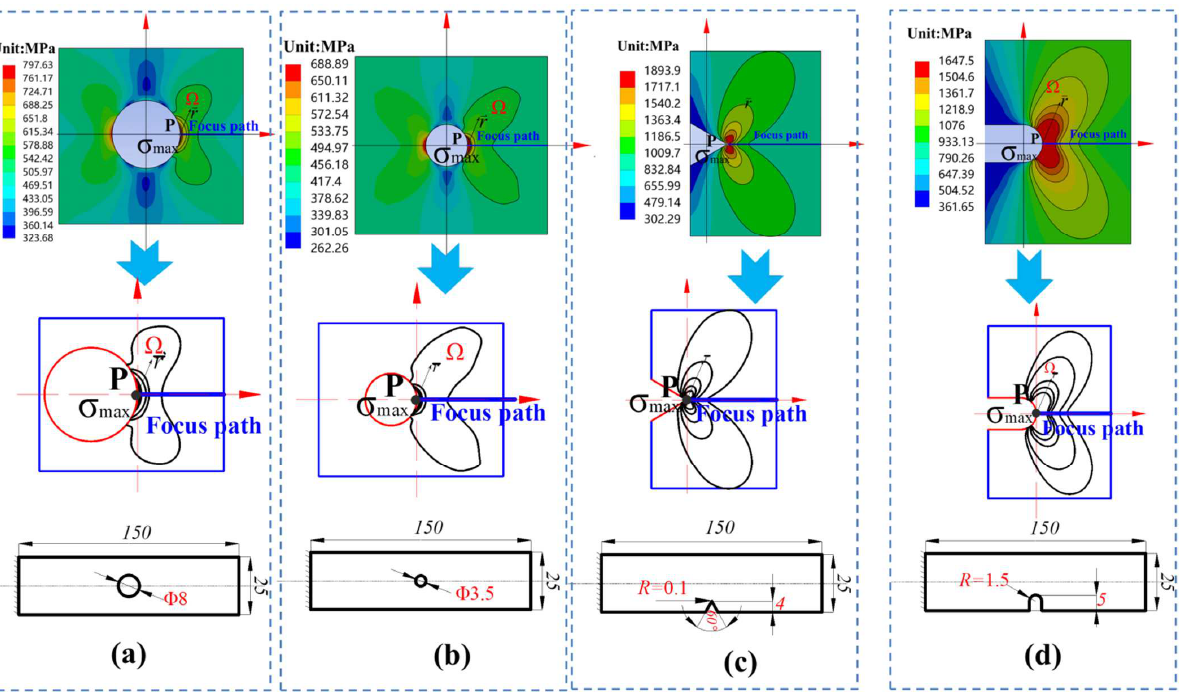
Figure 7. Elastic–plastic stress nephograms at the notch root of the four specimens under pressure of 251 MPa. ( a ) big circle hole plate, ( b ) little circle hole plate, ( c ) sharp V-notch plate, ( d ) U-notch plate.